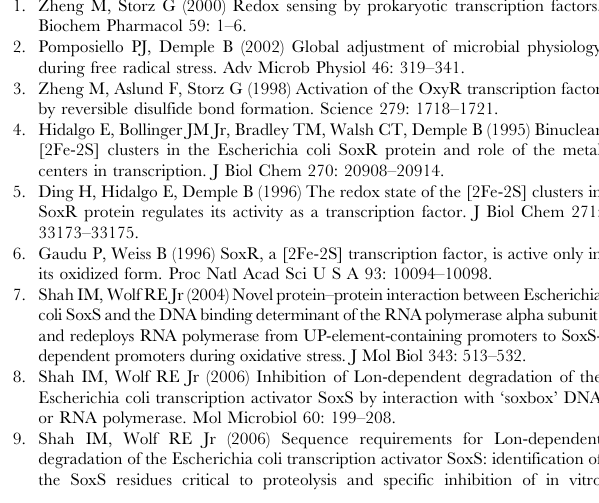
Supplemental Figure S2 The expression pattern of a SoxR dependent cluster (cluster 1) and a cluster containing 49 ribosome- related genes (cluster 31). Each graph shows mean change in the average ratio of log2 expression values of all genes in the cluster clustering on all three time-series experiments. Supplemental Table S1 List of genes from the clusters in Figure 3.